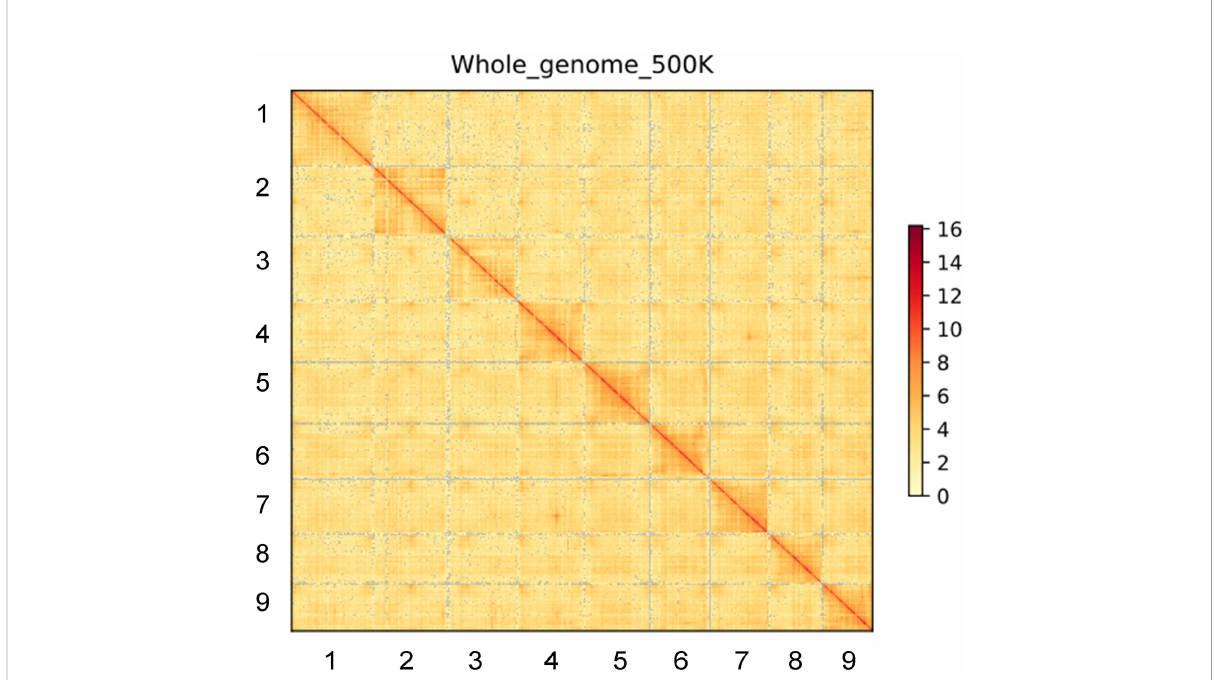
FIGURE 2 Integrated Hi-C interaction heatmap of B. Vulgaris IMA1 genome. The heatmap displays high-resolution single pseudo-chromosomes, which were scaffolded and composed independently. Lines are ordered by chromosomes length as follow:1, chr5; 2, chr4; 3, chr3; 4, chr7; 5, chr6; 6, chr9; 7, chr1; 8, chr8; 9,